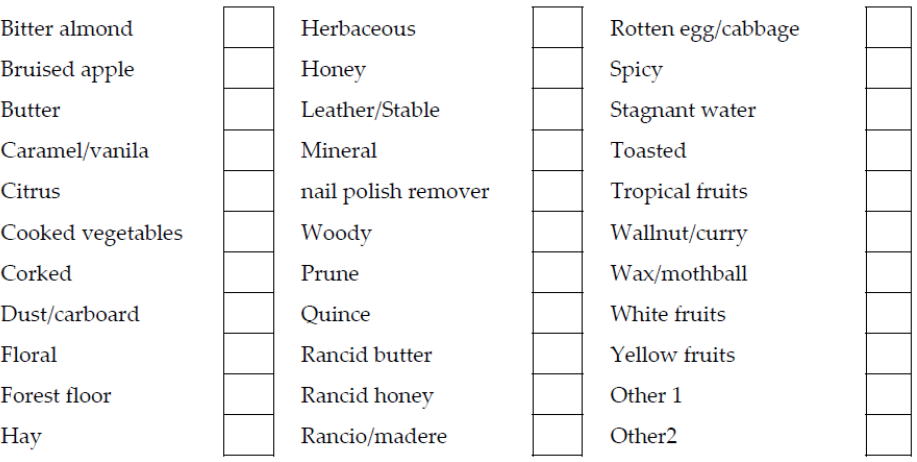
Figure 1. Ballot used for the general odor description (translated from French).